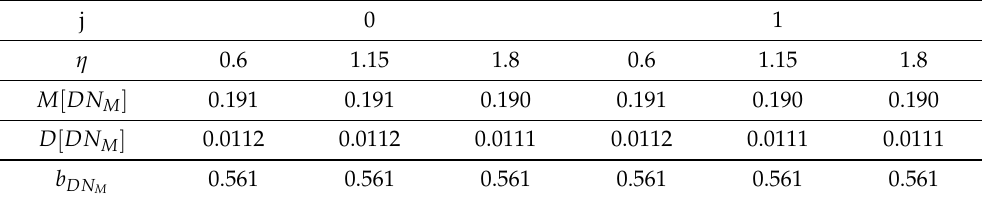
Table 7. Values of mathematical expectation and variance of statistics DN M .